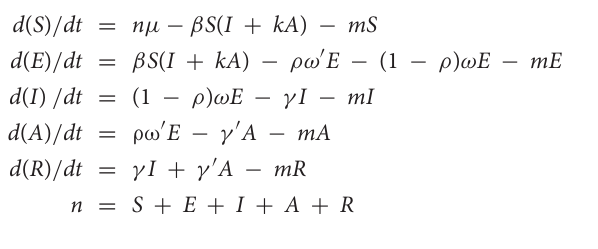
symptomatic and asymptomatic patients are defined as removed persons after an infectious period of 1/ γ and 1/ γ ′ , respectively.